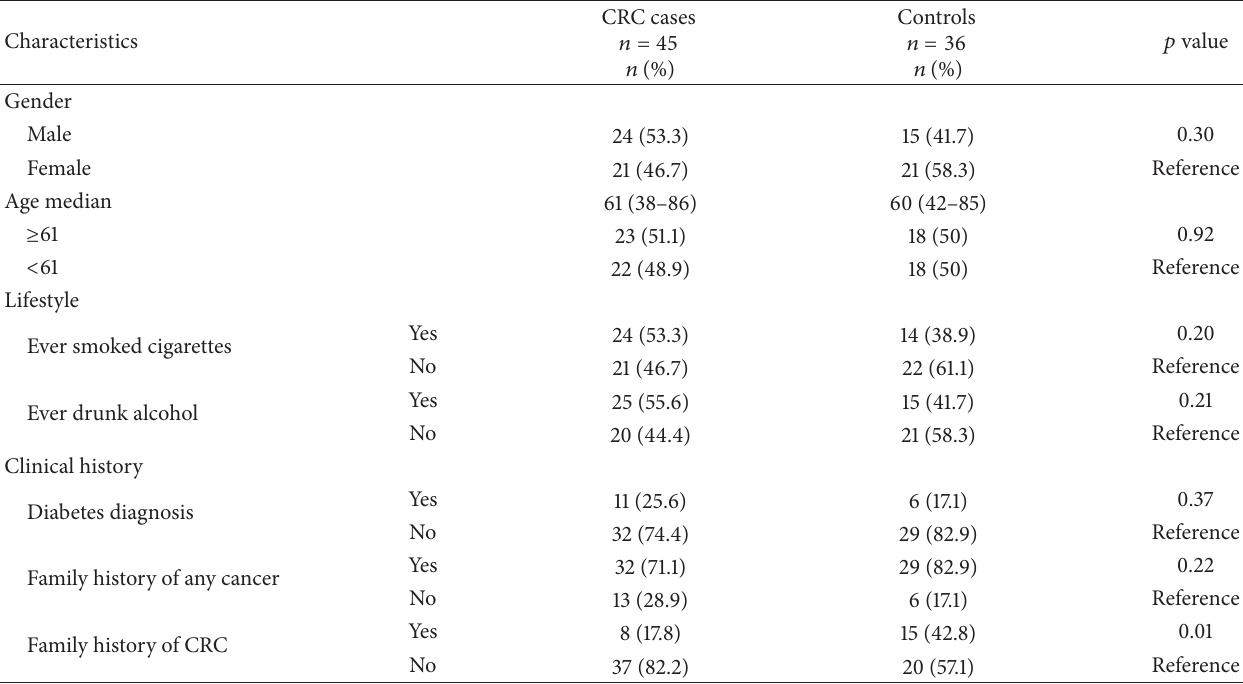
Table 1: Summary of demographic and clinical history characteristics of the study